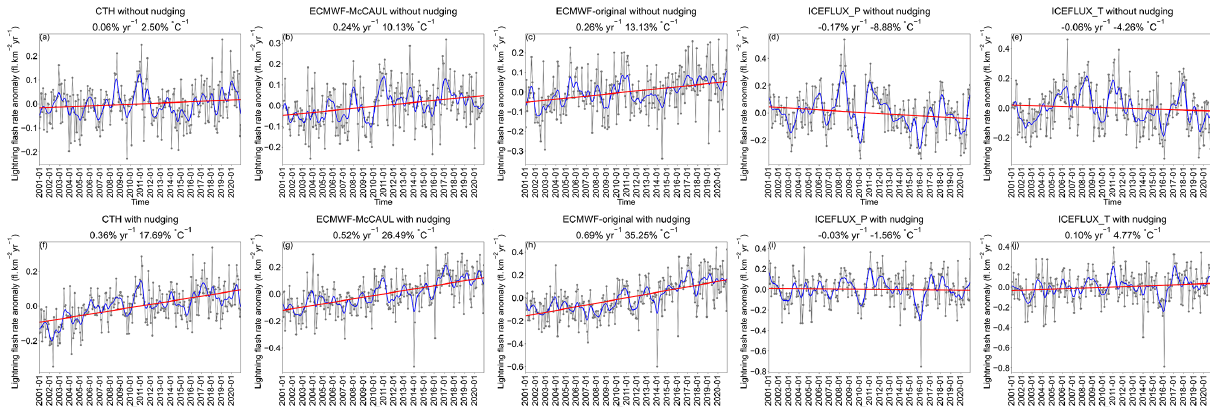
Figure 12. Global anomaly of lightning flash rates calculated from simulation results (2001–2020) using different lightning schemes. Pan- els (a) – (e) present results without nudging; panels (f) – (j) present results with nudging. The grey lines with points represent the monthly time series data on the global mean lightning flash rate anomaly. The blue curves represent the monthly time series data of the global mean lightning flash rate anomaly with the 1-D Gaussian (denoising) filter applied. The red lines are the fitting curves of the grey lines.